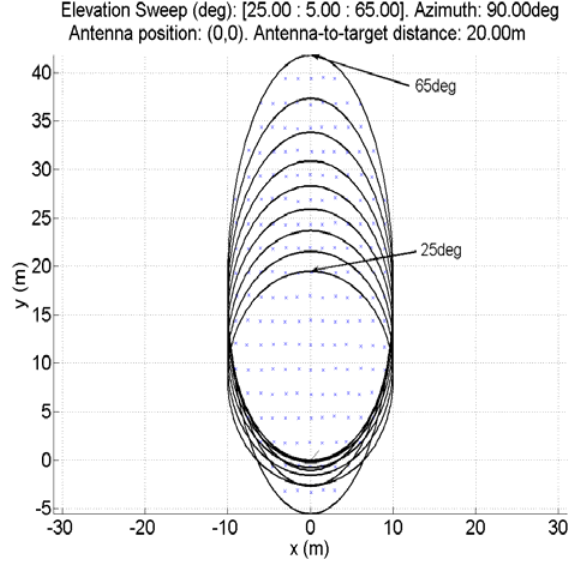
Figure 7. Field-Of-View of the antenna footprints for incidence angles from 25° to 65° in 5° steps (azimuthal angle equal to